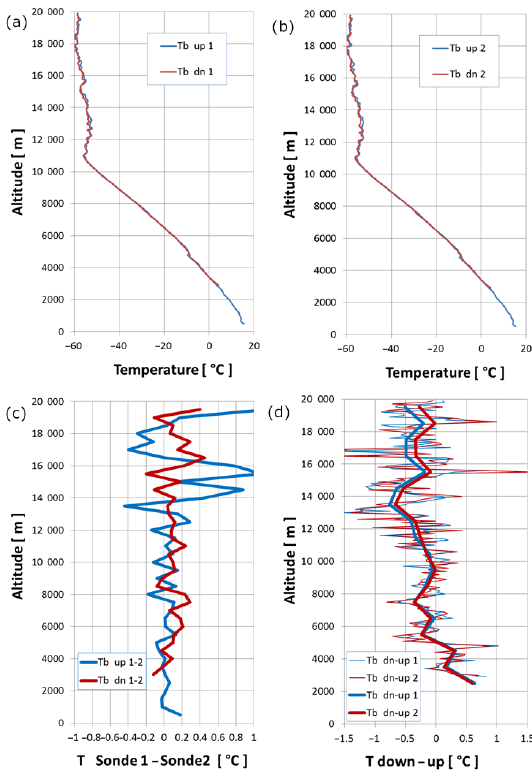
Figure 15. Temperature measurements by two SRS-C34 radioson- des during ascent to 20km and controlled descent using additional temperature sensors (Tb) mounted to the bottom of the radiosondes. Shown are (a) ascent and descent temperature profiles measured by sonde 1, (b) same as (a) but measured by sonde 2, (c) temperature differences between the two sondes and (d) descent–ascent temper- ature differences for each of the two sondes at vertical resolutions of 100m (thin curves) and 1000m (thick